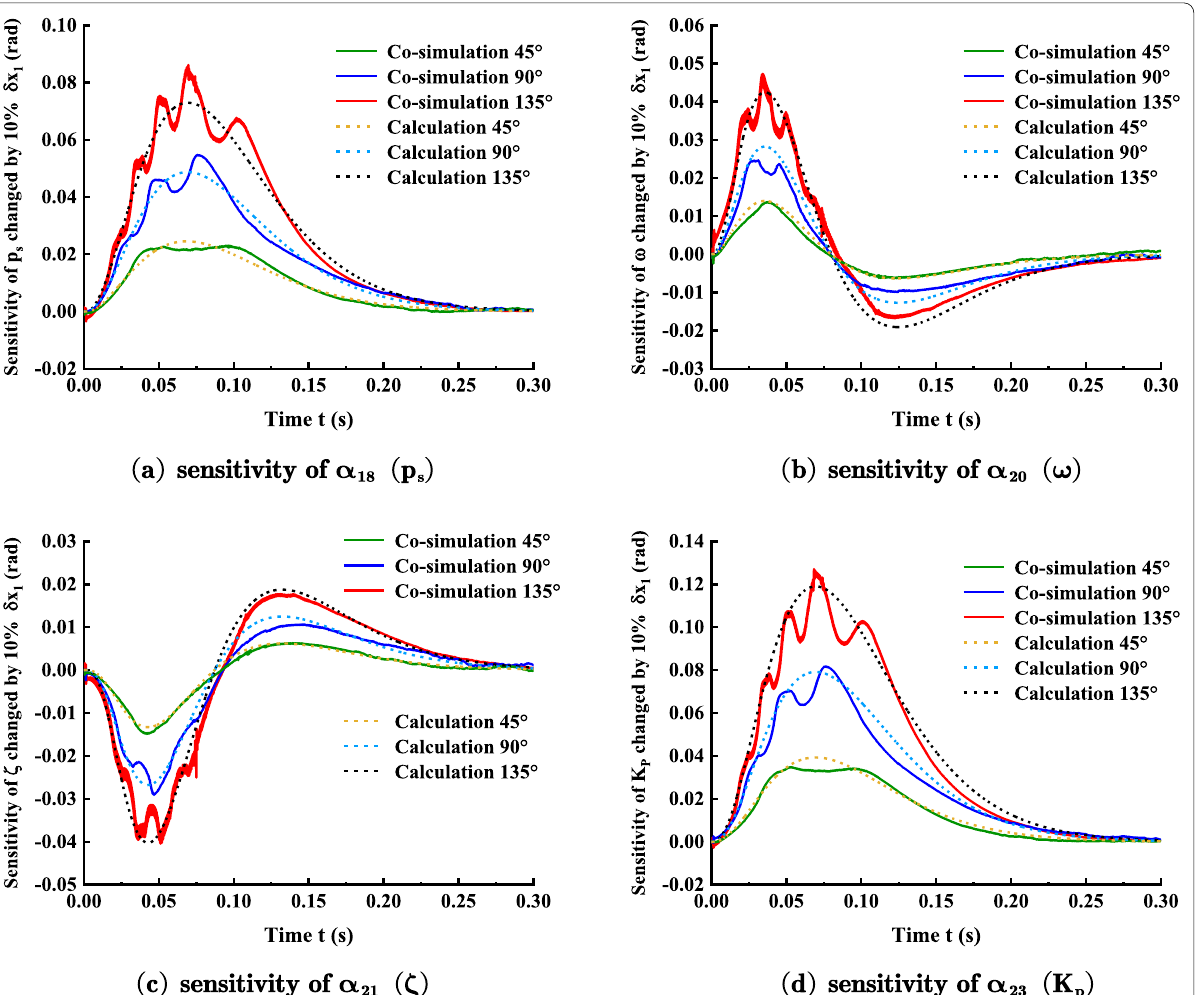
Figure 13 Comparison of theoretical and co-simulation values: change in rotation angle corresponding to each parameter under 100 N